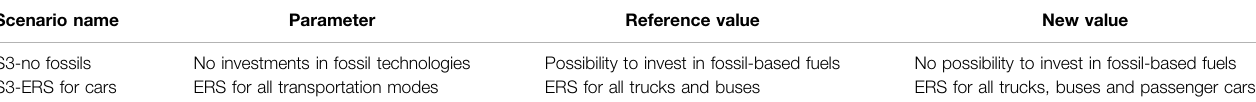
TABLE 3 | Parameters tested in a sensitivity analysis in ELIN-EPOD.